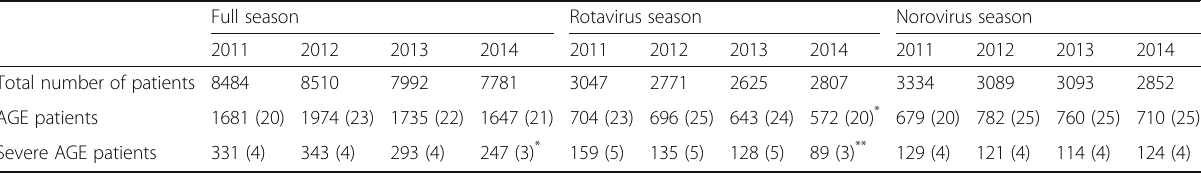
Table 1 Numbers and proportions of AGE and severe AGE patients aged 3 to 5